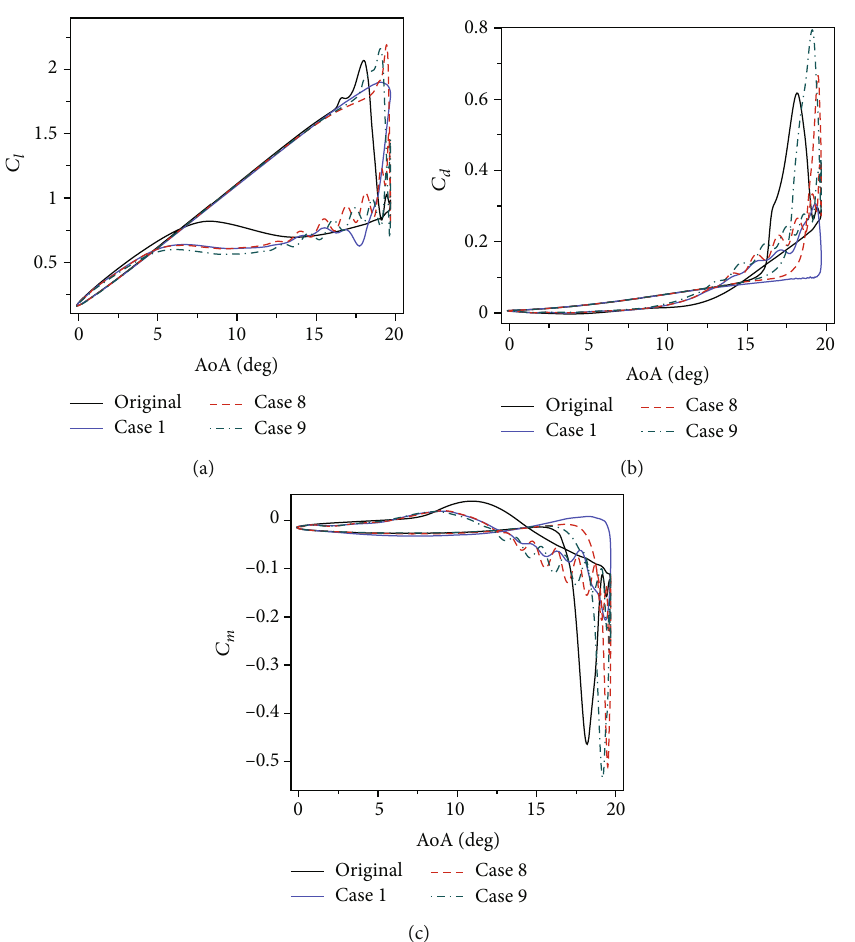
Figure 33: Comparison of aerodynamic coe ffi cients for Cases 1, 8, and 9: (a) lift coe ffi cients, (b) drag coe ffi cients, and (c) pitching moment coe ffi cients.